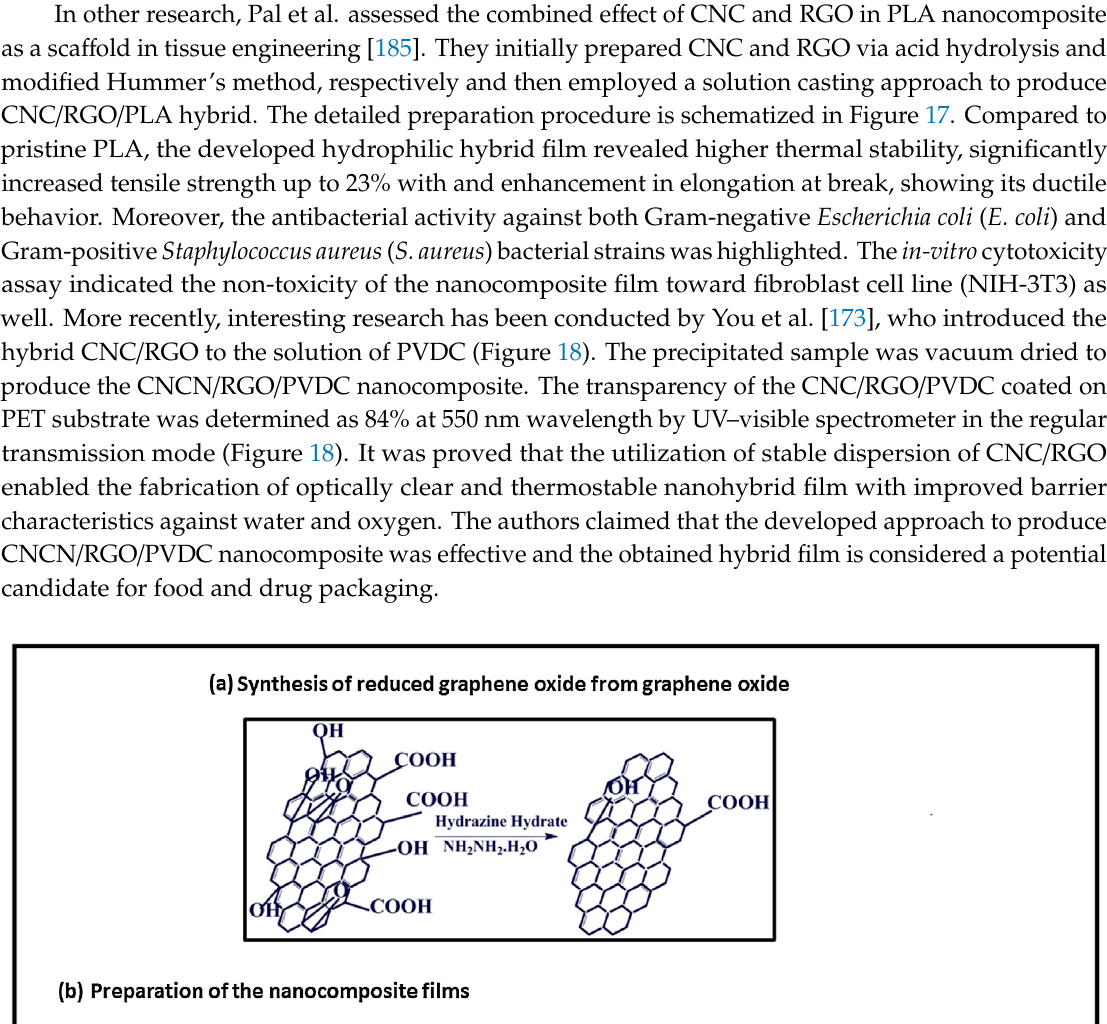
Figure 18. Dispersion stability of nanofillers. CNC, RGO and 1CNC:2RGO (1C:2R) hybrid in ( a ) THF:DMF co-solvent and ( b ) PVDC nanocomposite solutions of 0.1 wt. % fillers loading to PVDC. ( c ) Transmittance results of 0.1 wt. % PVDC/CNC, RGO and 1C:2R nanocomposite films. The 10 mm thick nanocomposite films were deposited on 125 mm thick PET substrates. ( d ) Large area (17 cm × 21 cm) PVDC/1C:2R–0.1 wt% nanocomposite film was obtained. Reproduced with permission from Reference [173]. Copyright ©2020, Elsevier. 5. Summary and Outlook